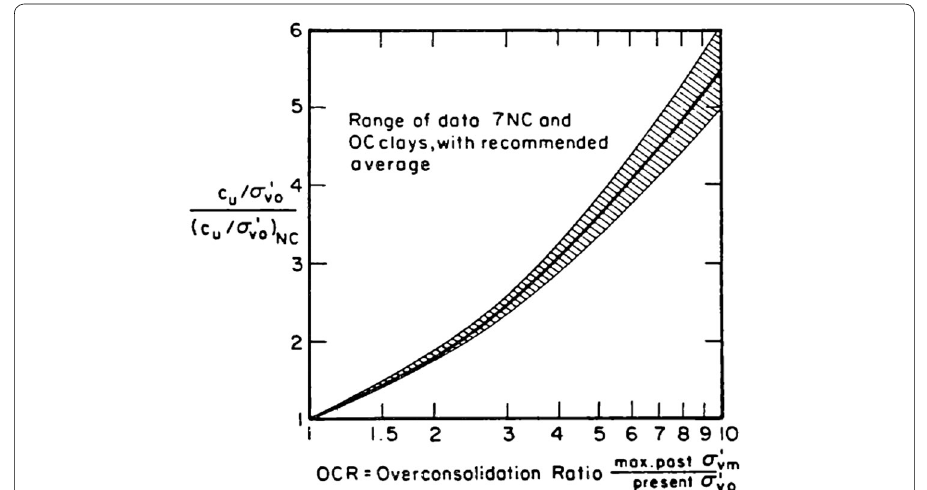
Fig. 2 Relationship of normalized undained soil cohesion and OCR (after